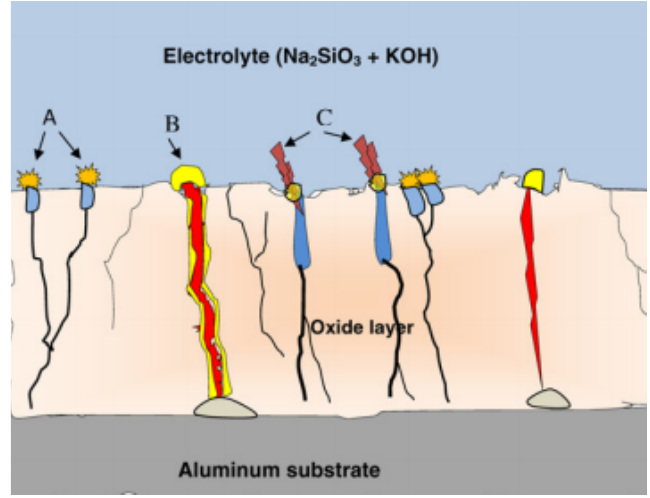
Figure 2. Diagram of the pattern of discharges formed during the MAO [37].